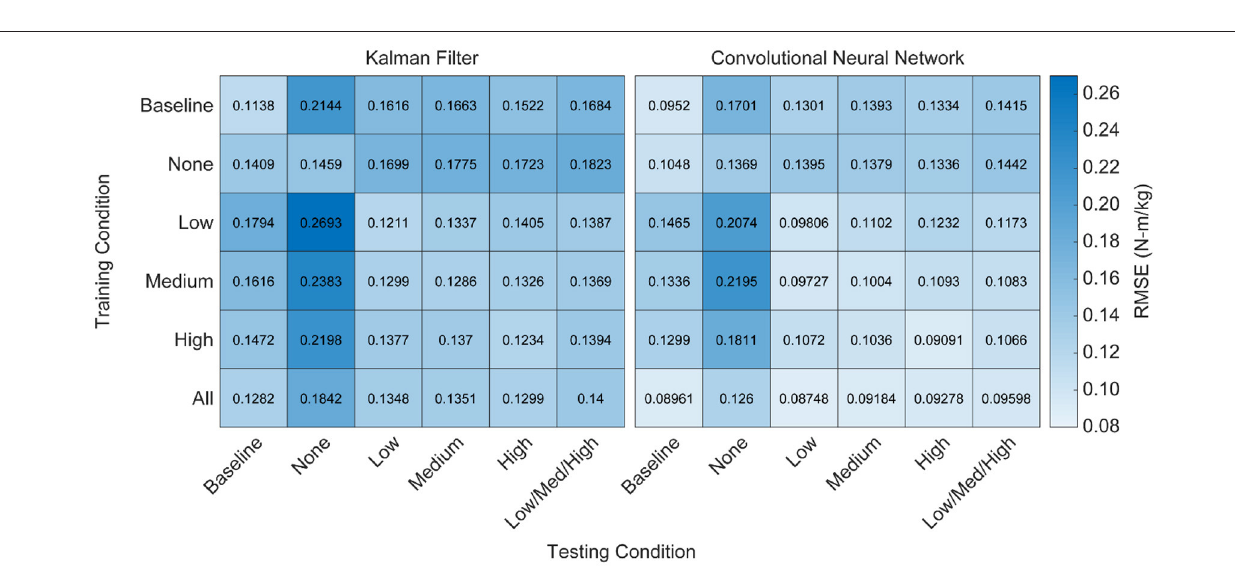
FIGURE 5 | Heatmap of algorithm performance under various training and testing conditions. Performance is shown as RMSE (N-m/kg) of algorithm predictions relative to the ground truth values of right and left hip torque in the sagittal plane. Lighter colors represent lower RMSE and better performance. Training and testing on the same condition led to strong performance for both algorithms, as indicated by low RMSE values along the diagonals. Testing on conditions that were not explicitly trained on resulted in worse performance, as indicated by high RMSE values off the diagonals. Training on all of the conditions improved the overall performance of the CNN when testing on various levels of exoskeleton assistance, but did not improve the overall performance of the KF. That is, diverse training data increased the adaptability of the CNN, but not the